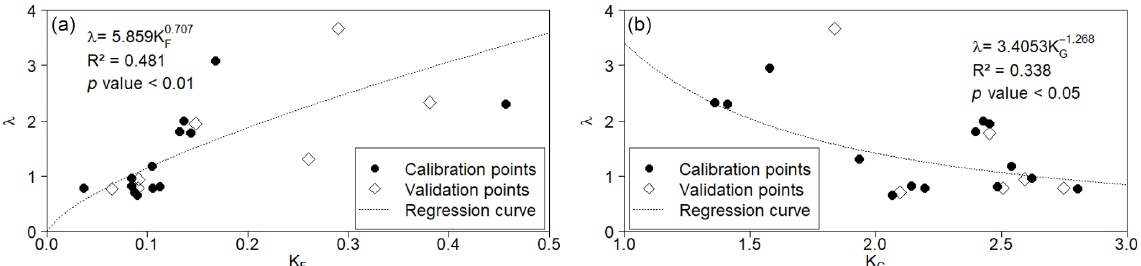
Figure 5. Correlations between the ratio ( λ = A o /A m ) and (a) the Gravelius coefficient ( K G ) and (b) the form factor ( K F ) for 21 monitored cross sections at the Madalena representative basin (MRB). Black dots refer to calibration cross sections, and white diamonds refer to validation cross sections. The R 2 values indicated in the plots are for the calibration. The validation R 2 values were 0.10 for K G and 0.54 for K F